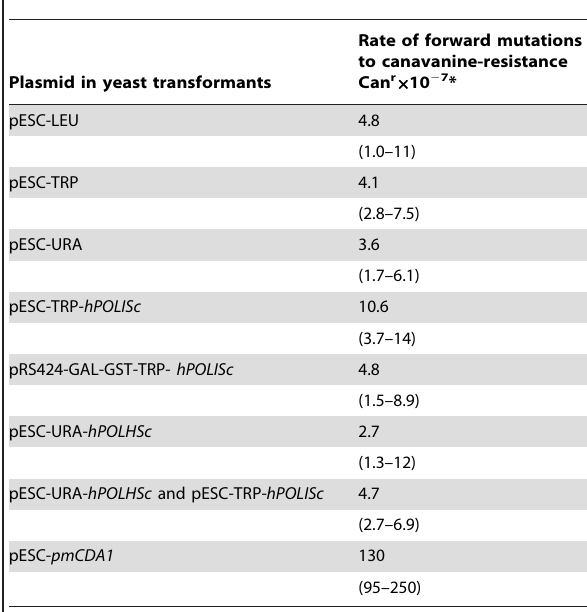
Table 1. Expression of the hPOLISc or hPOLHSc in yeast is